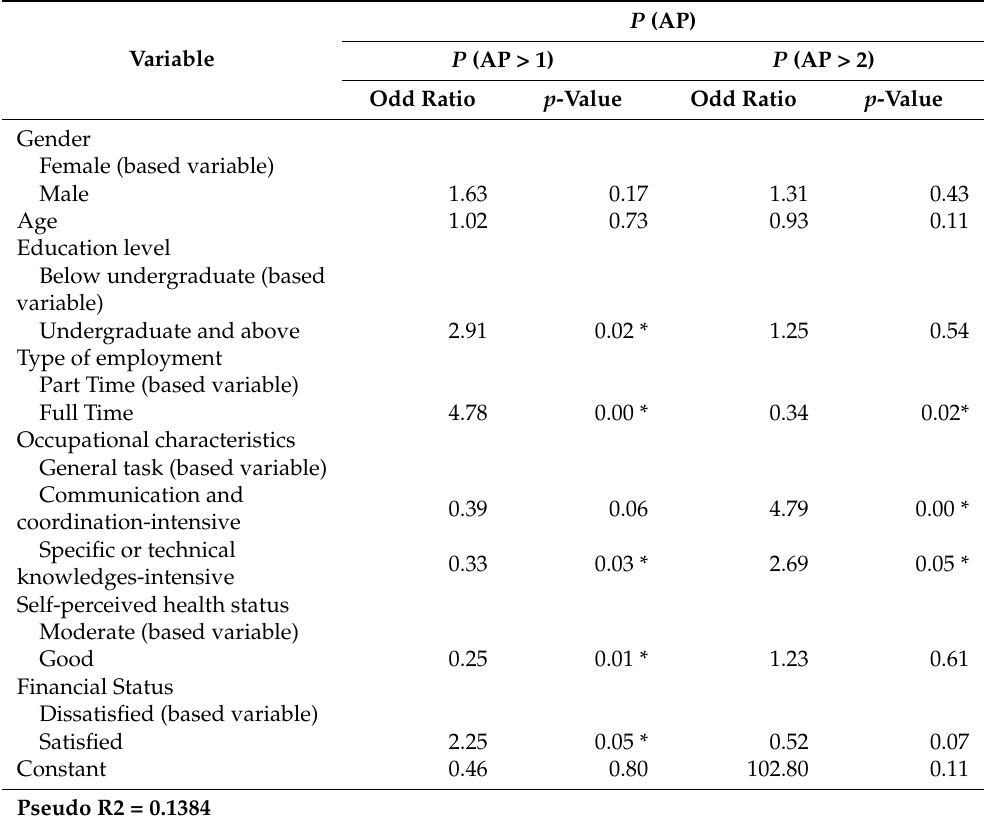
Table 4. Gologit regression